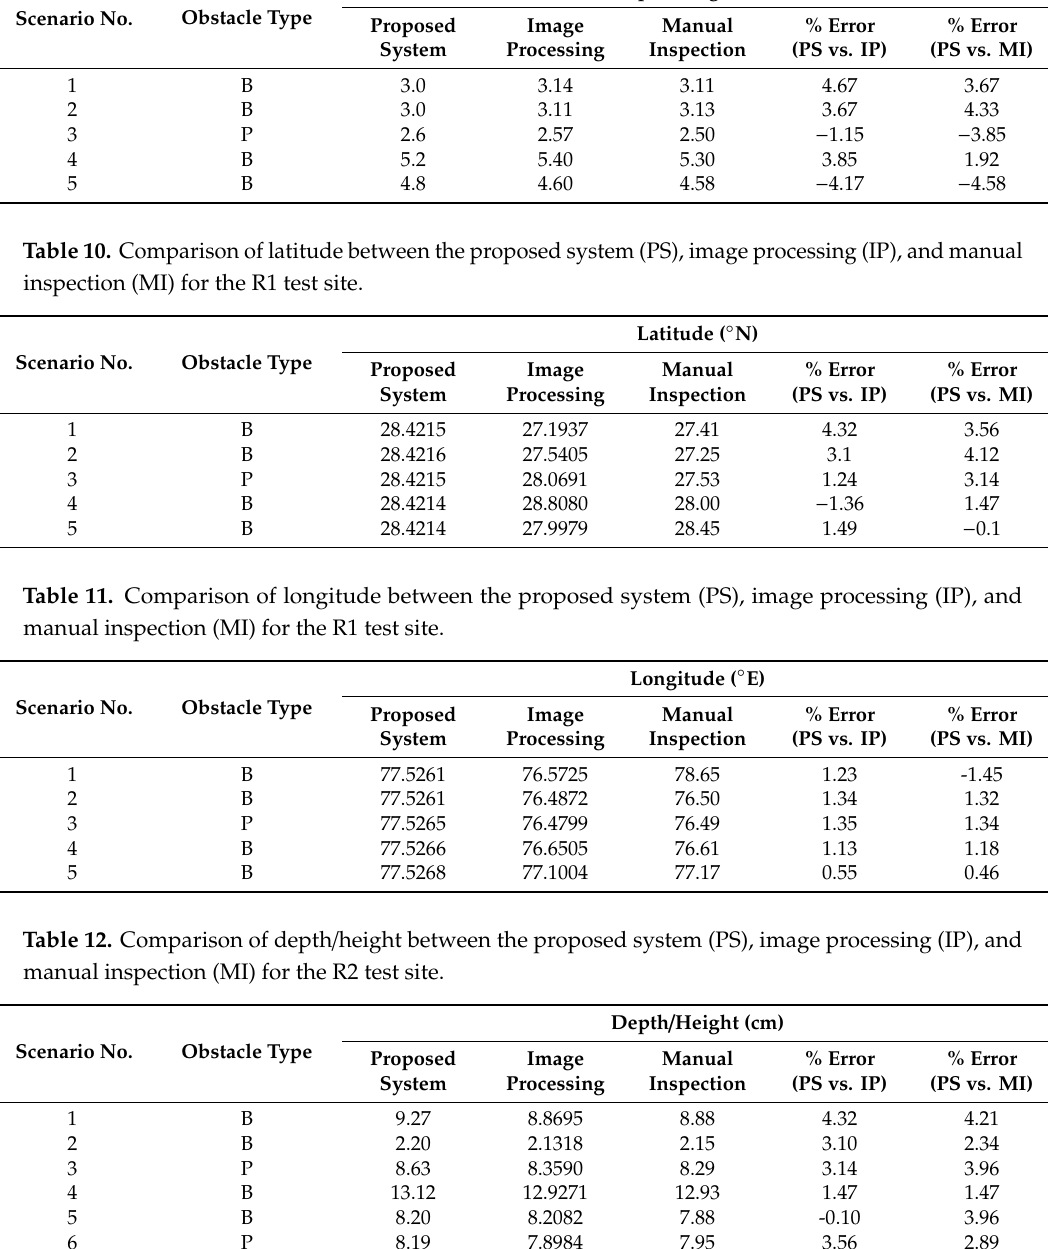
Table 9. Comparison of depth / height between the proposed system (PS), image processing (IP), and manual inspection (MI) for the R1 test site.